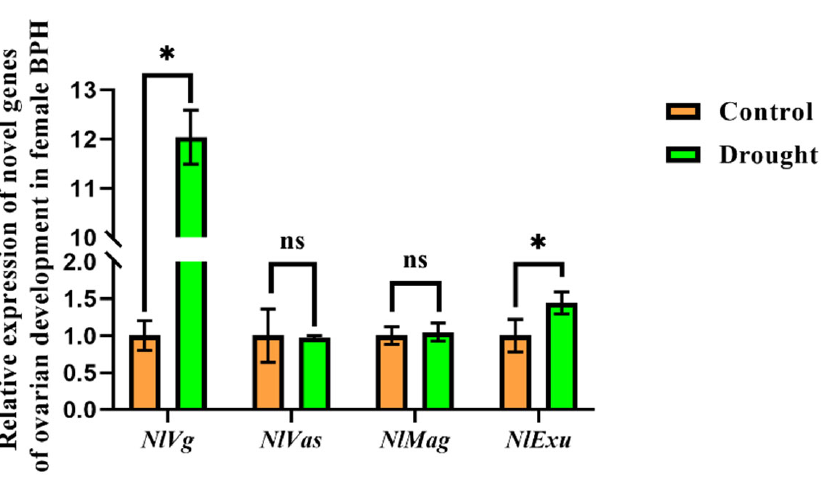
Figure 2. Relative expression of NlVg , NlVas, NlMag and NlExu in female BPH after feeding on drought-stressed and non-stressed rice. Data represent means ± SE. * represents significant differ- ences in relative expression ( PLSD test, p < 0.05).